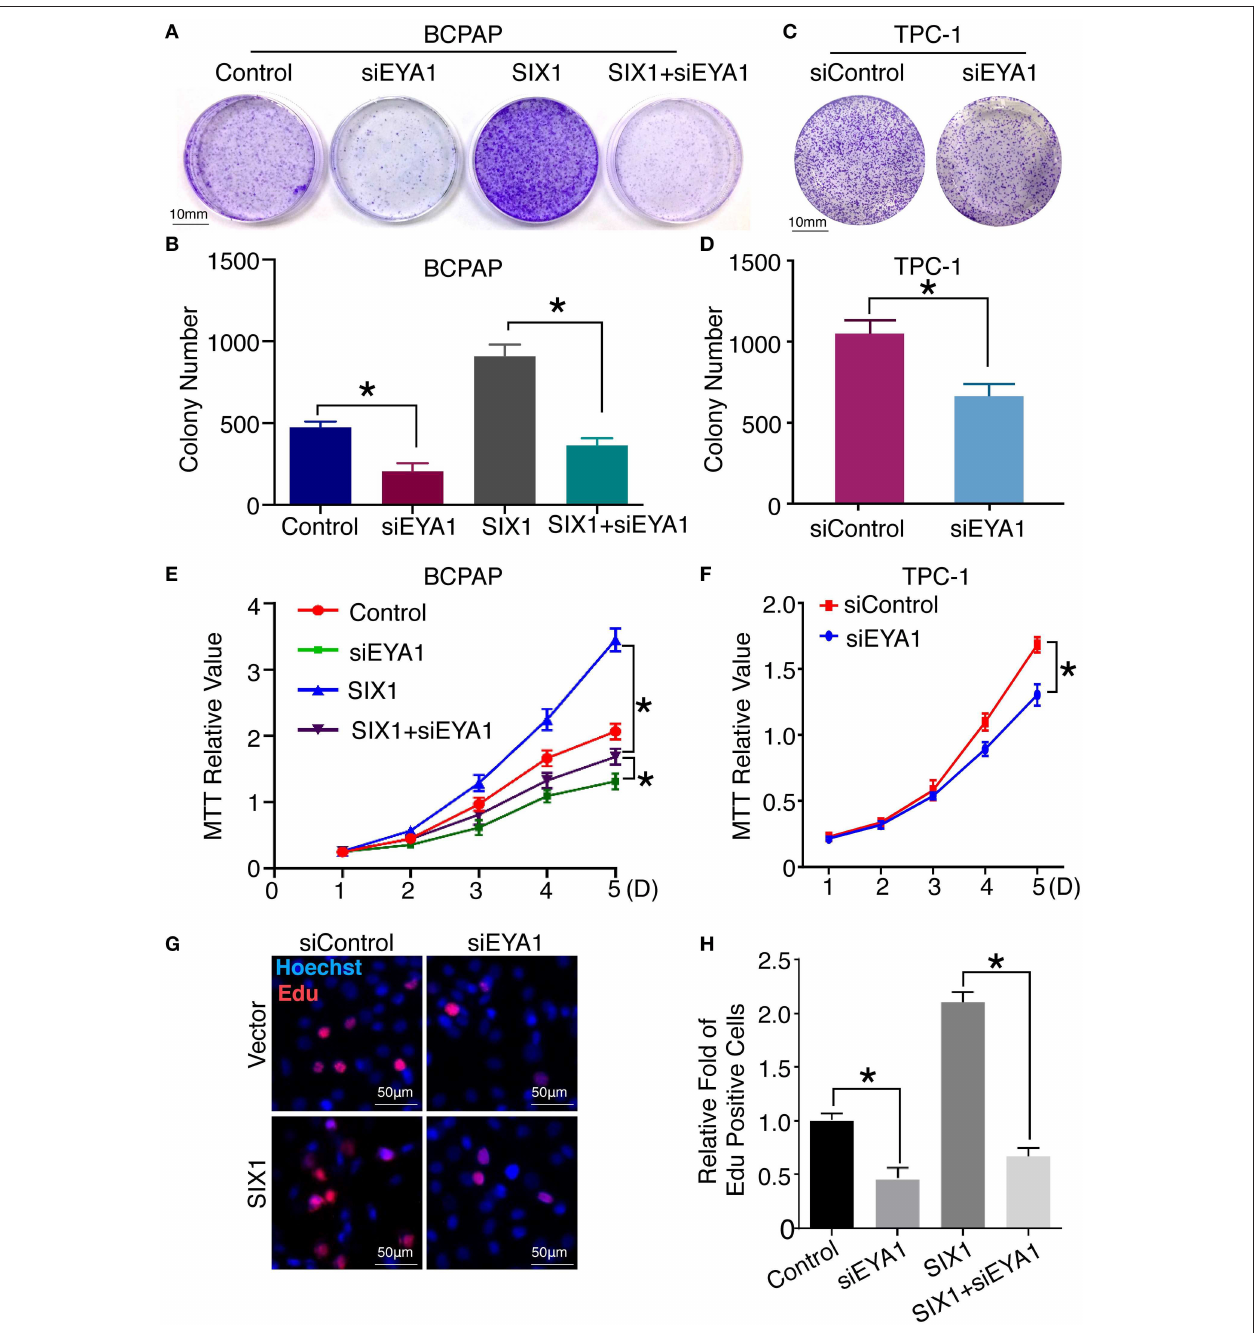
FIGURE 6 | Interaction of SIX1 and EYA1 determined PTC cells proliferation. Representative image of colony formation from BCPAP cells with SIX1 overexpression and/or siEYA1 (A) and quantitative analysis ( n = 3) (B) . Representative image of colony formation from TPC-1 cells with siEYA1 (C) and quantitative analysis ( n = 3) (D) . MTT assay of BCPAP cells with SIX1 overexpression and/or siEYA1 ( n = 5) (E) . MTT assay of TPC-1 cells with siEYA1( n = 5) (F) . Representative images of EdU assay of BCPAP cells with SIX1 overexpression and/or siEYA1 (G) and quantitative analysis ( n = 3) (H) . * p <